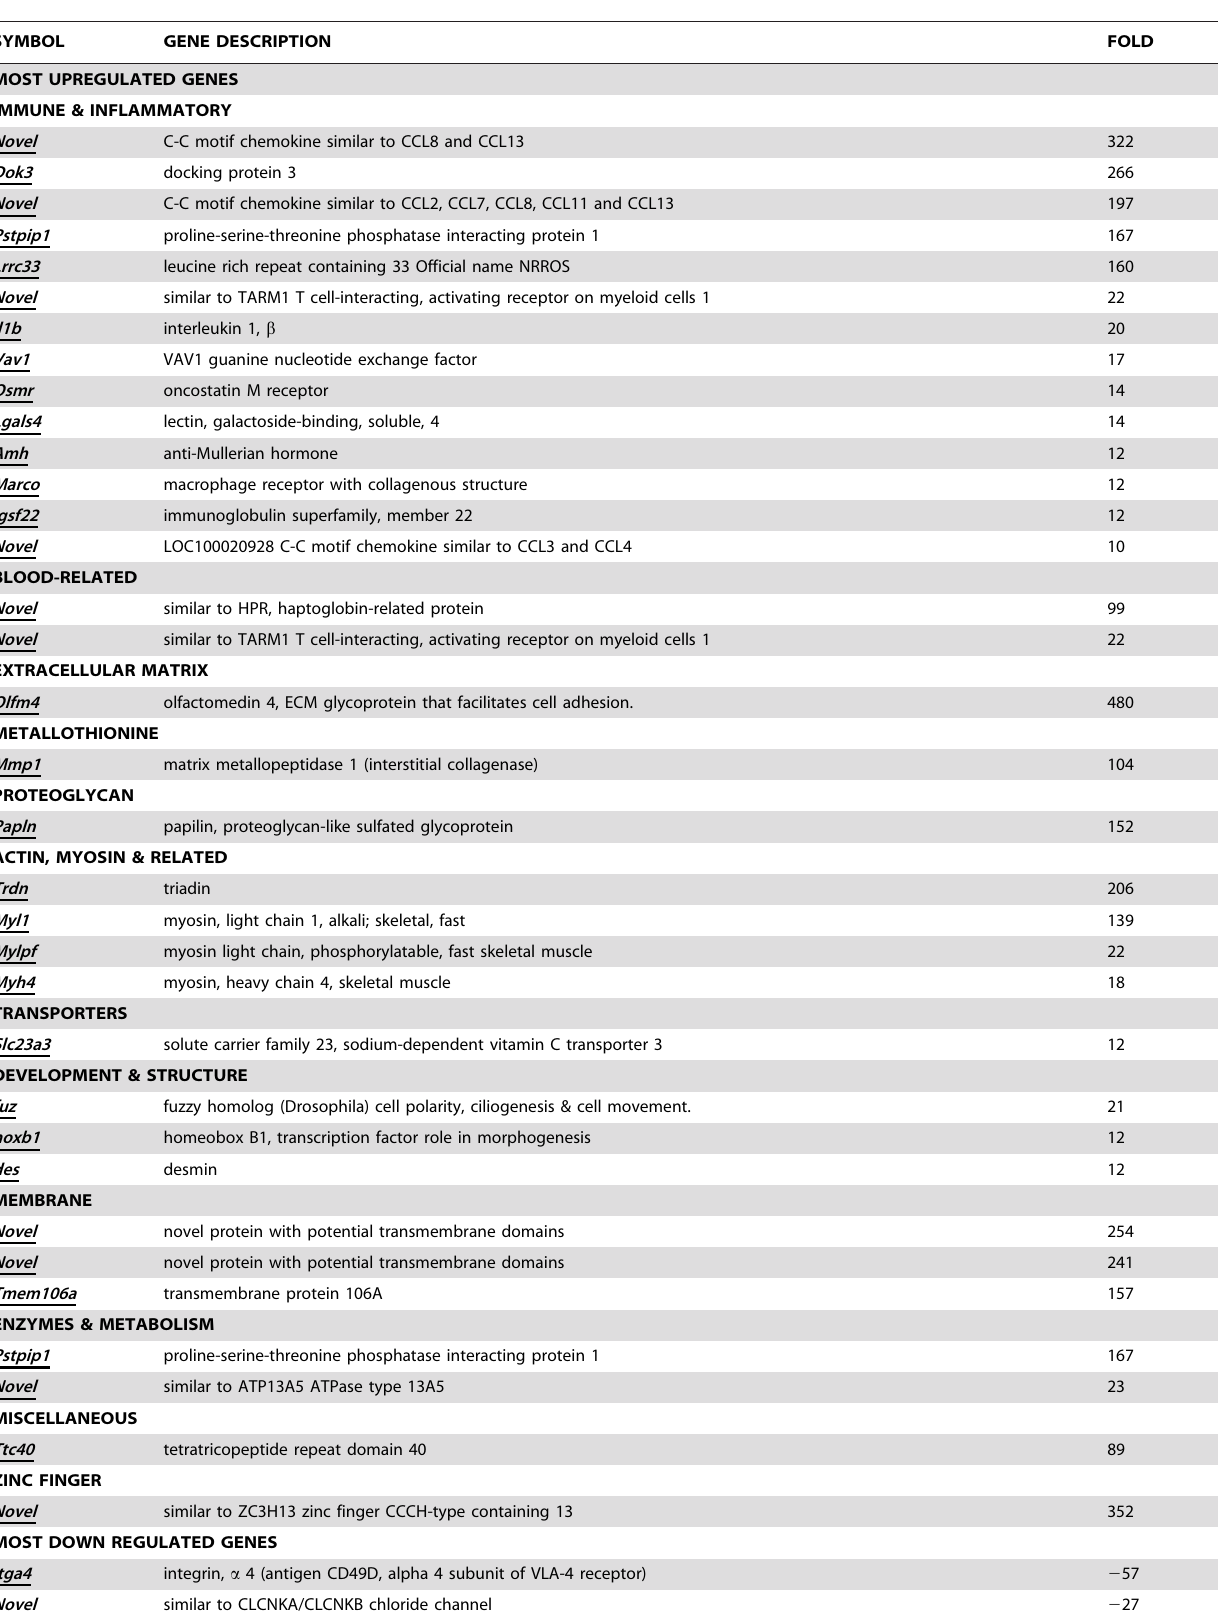
Table 5. Genes that changed most in expression ( 6 $ 10 FOLD) 24 h following spinal cord injury at P28.